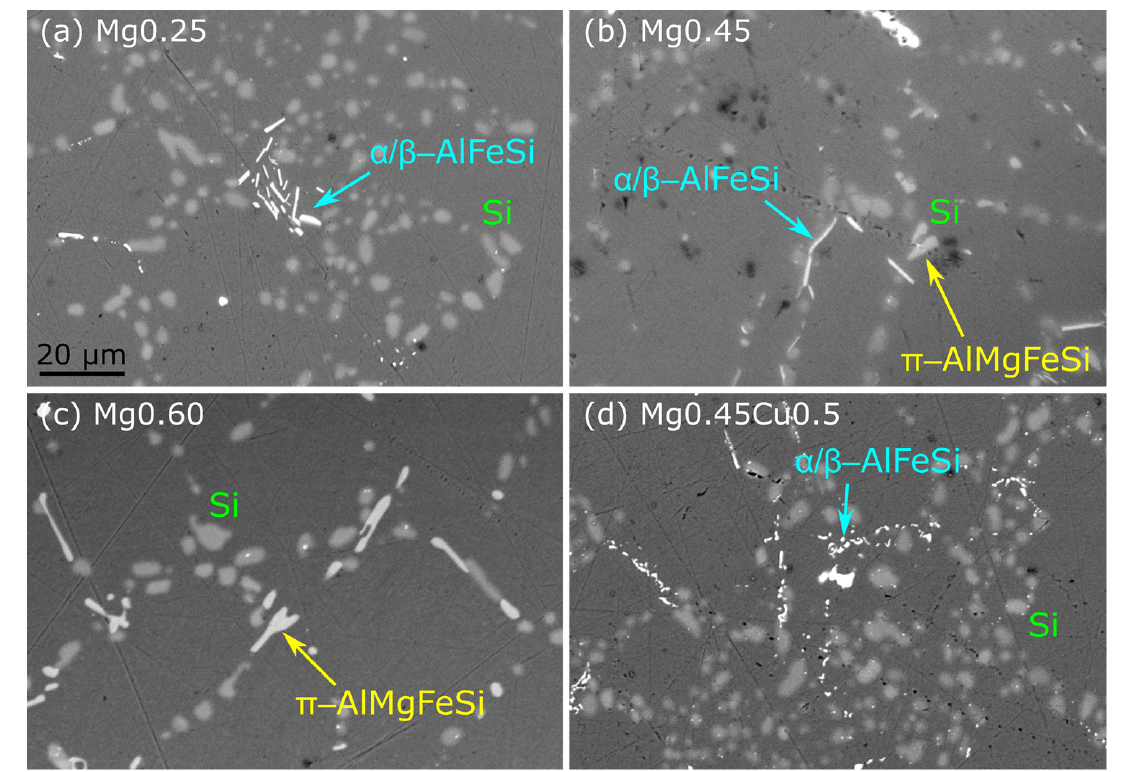
Figure 3. Backscattered electron SEM image of the microstructure of the 4 alloys in peak age condition (1 h RT, 5 h at 175 °C).